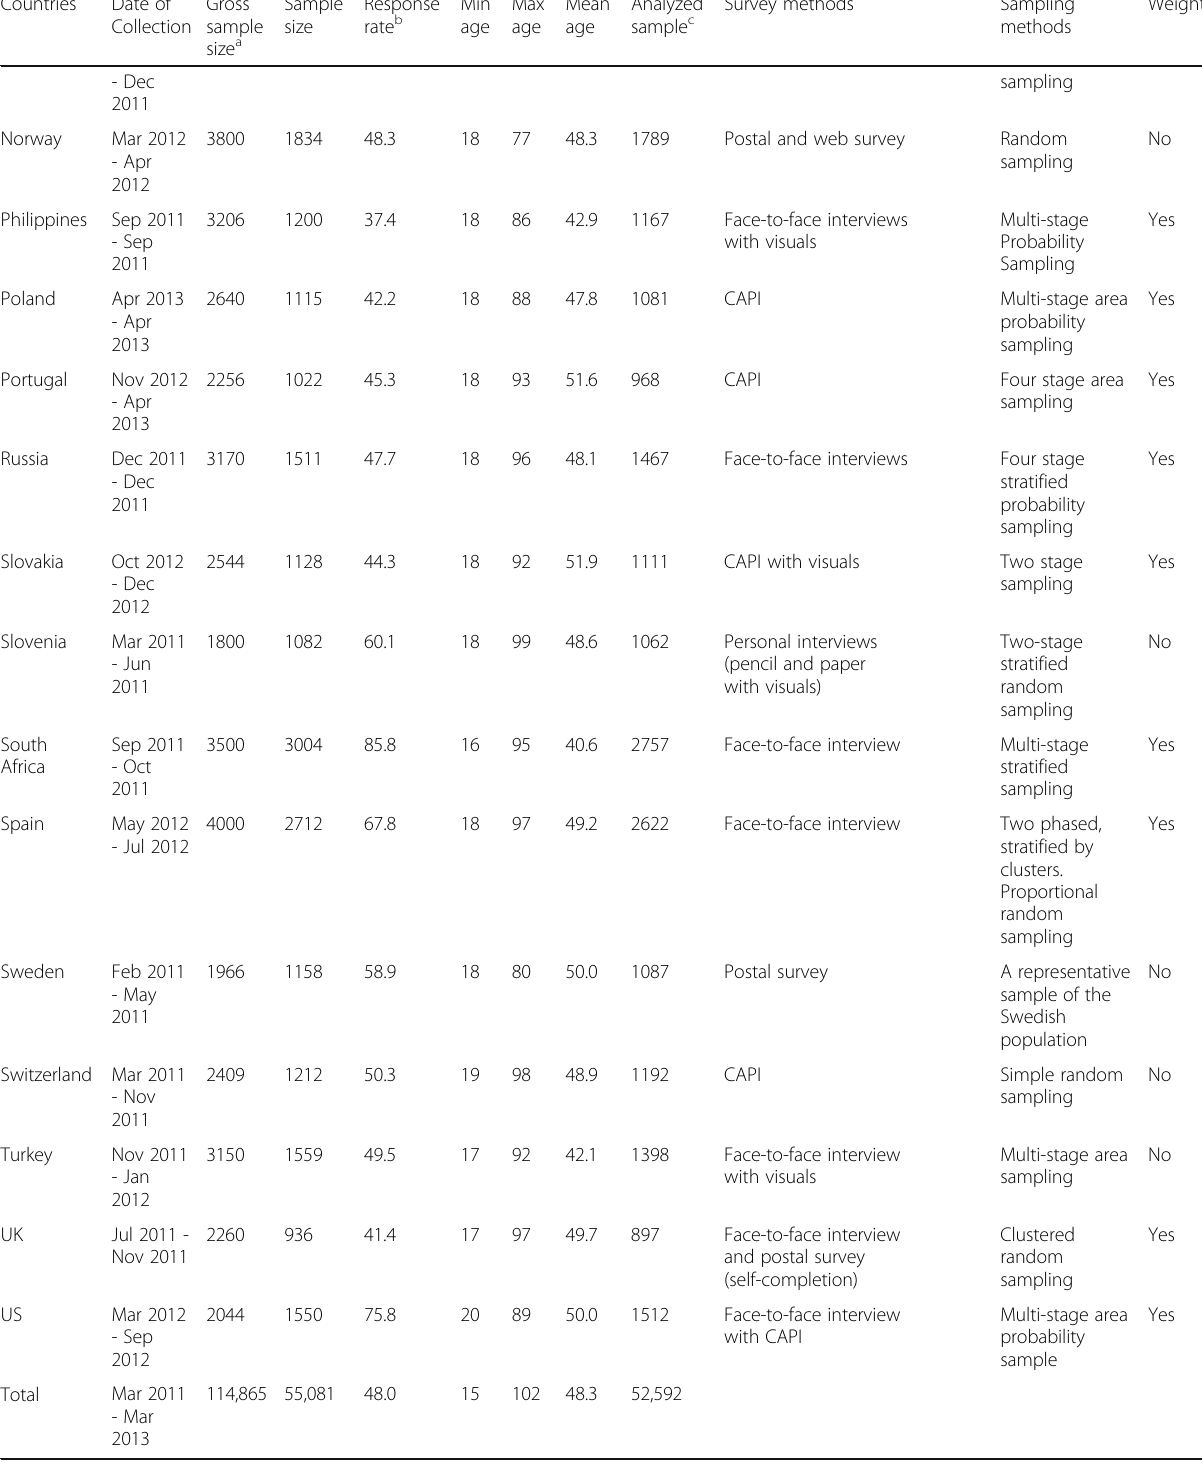
Table 1 Social survey summary of each of the 32 target countries (Continued)